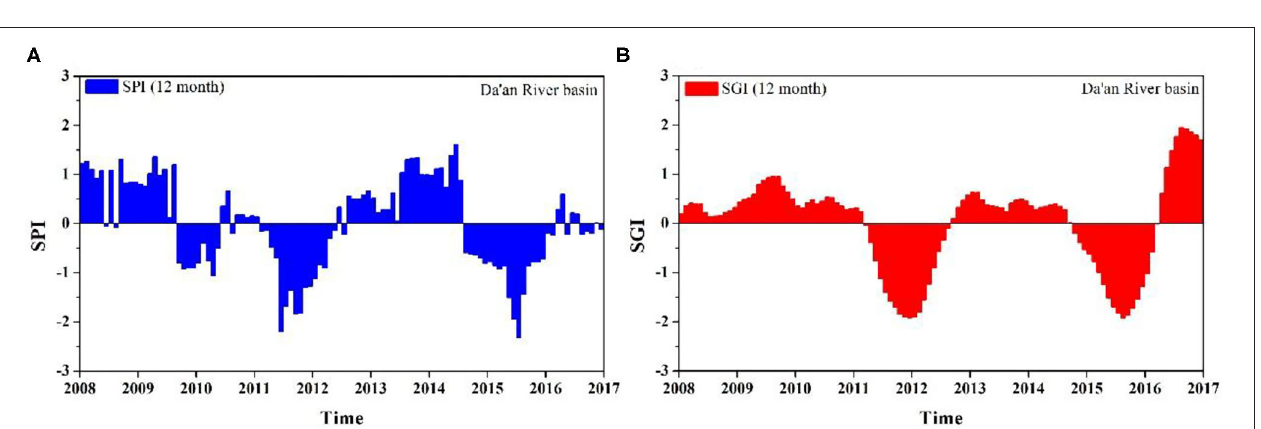
FIGURE 2 | Cumulative rainfall (SPI) at different time scales (using the Da’an River as an example).